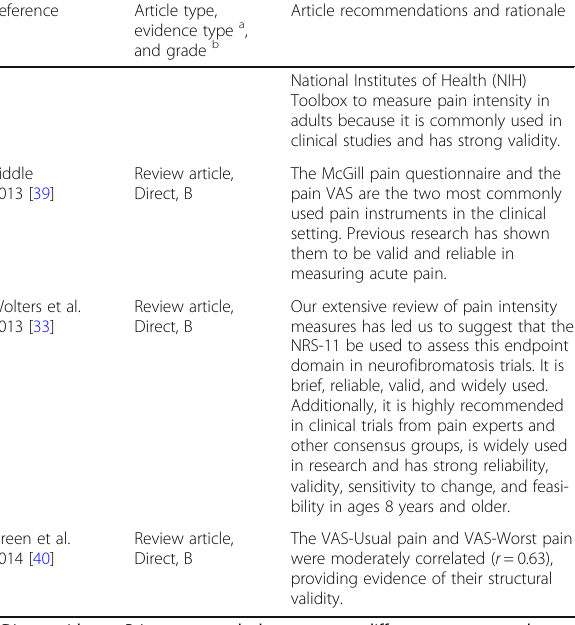
Table 1 Summary of key evidence to support response scale